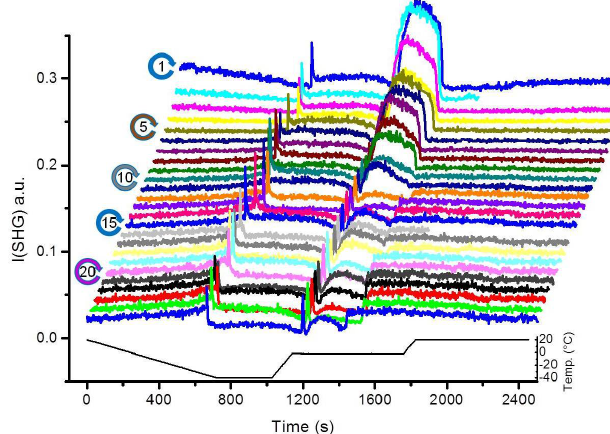
Figure 2. SHG signal at pH 3 solution–silica interface (I(SHG); a.u. stands for arbitrary units) as a function of time for 25 successive TP cycles. Due to technical problem, some data could be lost during the experiment (e.g., the uncompleted scans of cycle 2 and 16 in the presented